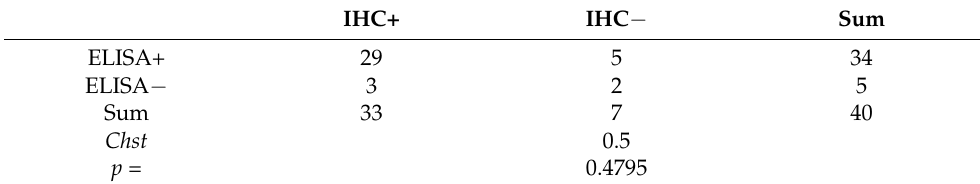
Table 8. IHC and ELISA comparison by Chi-square